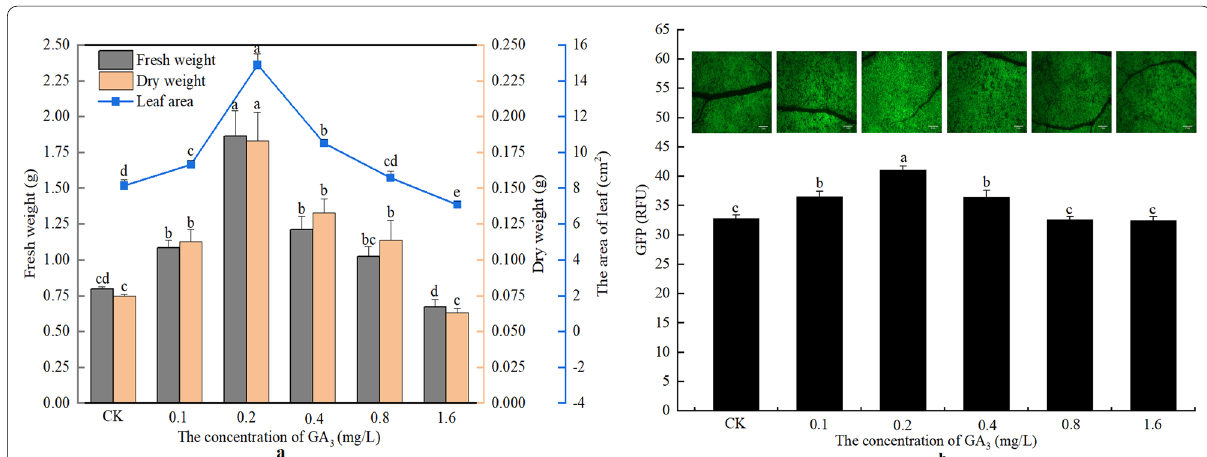
Fig. 2 The changes in biomass and GFP fluorescence intensity of seedlings under different GA 3 concentrations. a The changes of fresh weight, dry weight, and leaf area of the seedlings after treatment with different concentrations of GA 3 . b The changes in GFP fluorescence intensity in the leaves of the seedlings treated with different concentrations of GA 3 . Bar 2 mm. CK, Treatment with water; GA 3 : gibberellins 3 . The values of RFU (relative = fluorescence unit) are average standard error (SE) of three individual replicates. Different lowercase letters indicate that there are significant ± differences in the same parameter among the treatment with different concentrations of GA3 at the P < 0.05 level